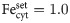
Regulatory loop of high affinity iron uptake and cytosolic iron homeostasis based on an iron-dependent IRT1 degradation.(a) Scheme of the control loop. Feext and Fecyt denote external and cytosolic iron, respectively. IRT1 and IRT1 denote mRNA and its protein, respectively. The extracellular iron concentration, Feext, is allowed to change to different but constant levels. (b) Homeostasis in cytosolic iron levels (Fecyt) with respect to sufficient and low external iron conditions. The set-point for the level of cytosolic iron is given by Eq (12) and is arbitrarily set to Fecytset=1.0. In the first phase (time t = 0 to t = 50) Feext = 5.0 and relative high. To keep iron at its homeostatic set-point during this phase the required concentration of IRT1 is relative low. In the second phase starting at t = 50 (arrow) Feext is reduced to 0.5. Due to this reduction the IRT1 level is increased to keep the cytosolic iron concentration close at its set-point. In the third phase (t = 100 to t = 150) iron is resupplied and IRT1 levels decrease again. Other rate parameters remain unchanged during the three phases, i.e. k1 = 1.0, k2 = 2.0, k3 = 1.0 × 102, k4 = 1.0 × 102, k5 = 1.0 × 102, VmaxEset=2.0×102, KMEset=1.0×10-4, and KaFe=1.0. Initial concentrations are Fecyt,0 = 1.0, IRT10 = 1.0, and IRT10 = 0.4. (c) Representation of results in a ‘blot-like’ manner. +Fe and −Fe denote sufficient and low external ion conditions, respectively. For each component (IRT1, IRT1) the gray levels (0–100%) reflect the relative IRT1/IRT1 concentrations at +Fe and −Fe conditions. (d) Experimental data, slightly rearranged from Fig 6A in Ref. [21].